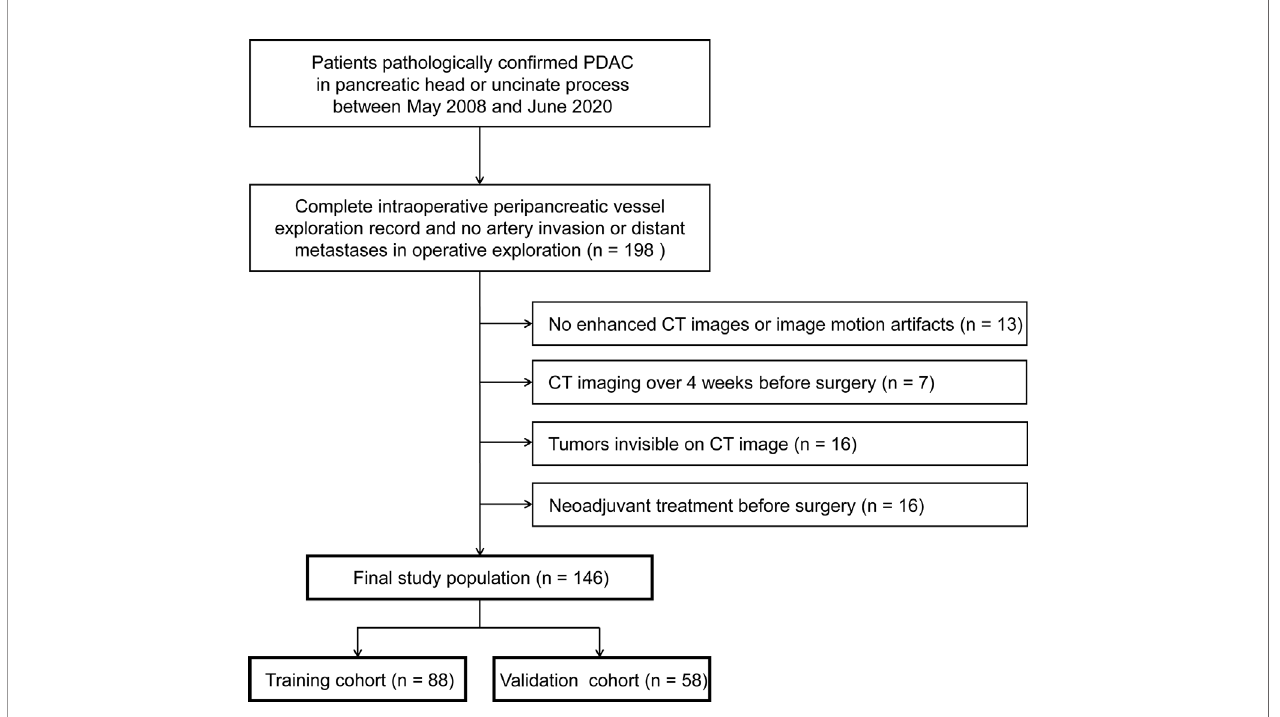
FIGURE 1 | Flow diagram of the study sample. PDAC, pancreatic ductal